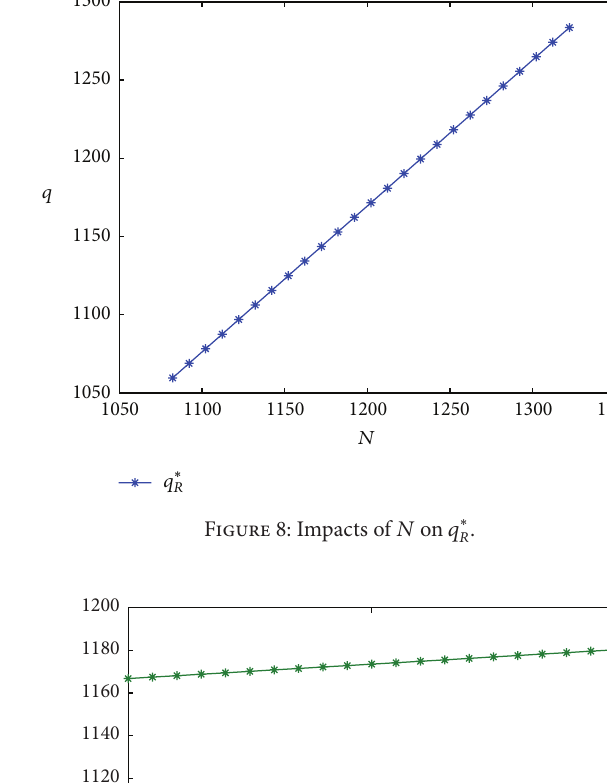
Figure 6: Impacts of 𝜎 on 𝑓 ∗ .